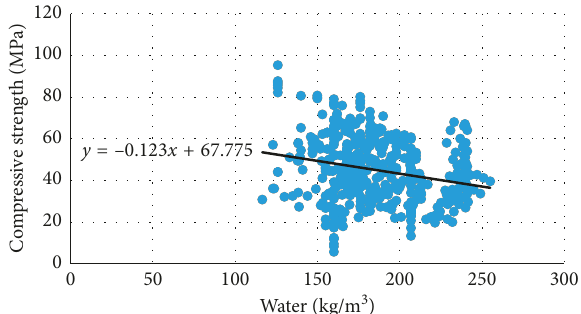
Figure 5: Distribution of compressive strength and water for the training samples of the CSPNN.